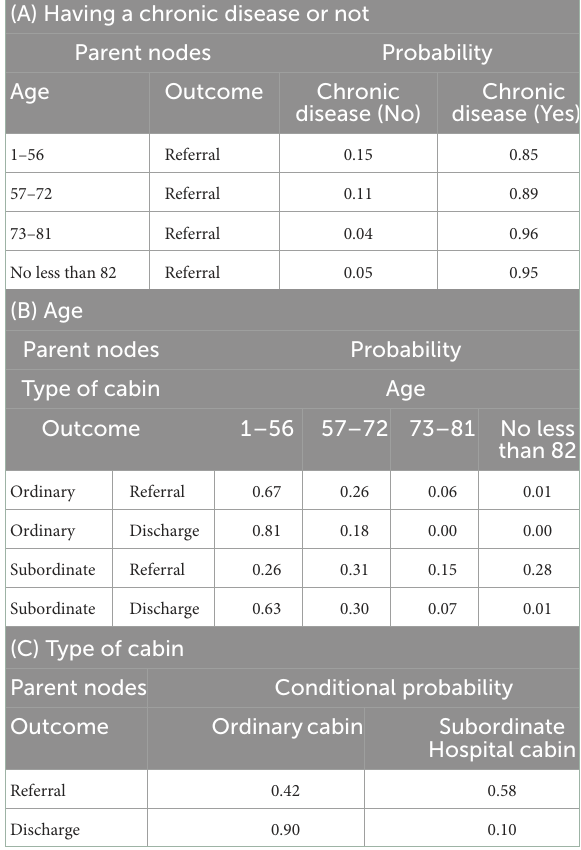
TABLE 3 Conditional probabilities of having a chronic disease or not, age and type of cabin.